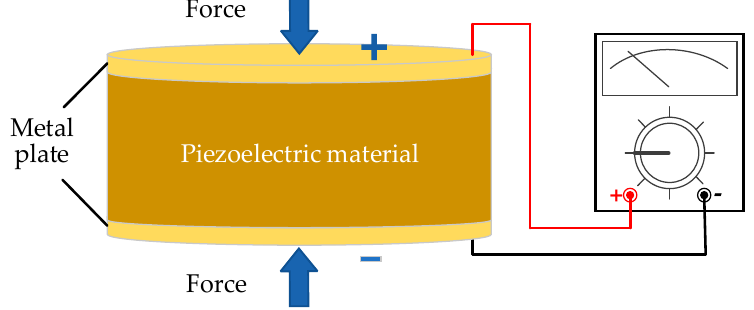
Figure 11. Direct piezoelectric effect principle. two common representative piezoelectric